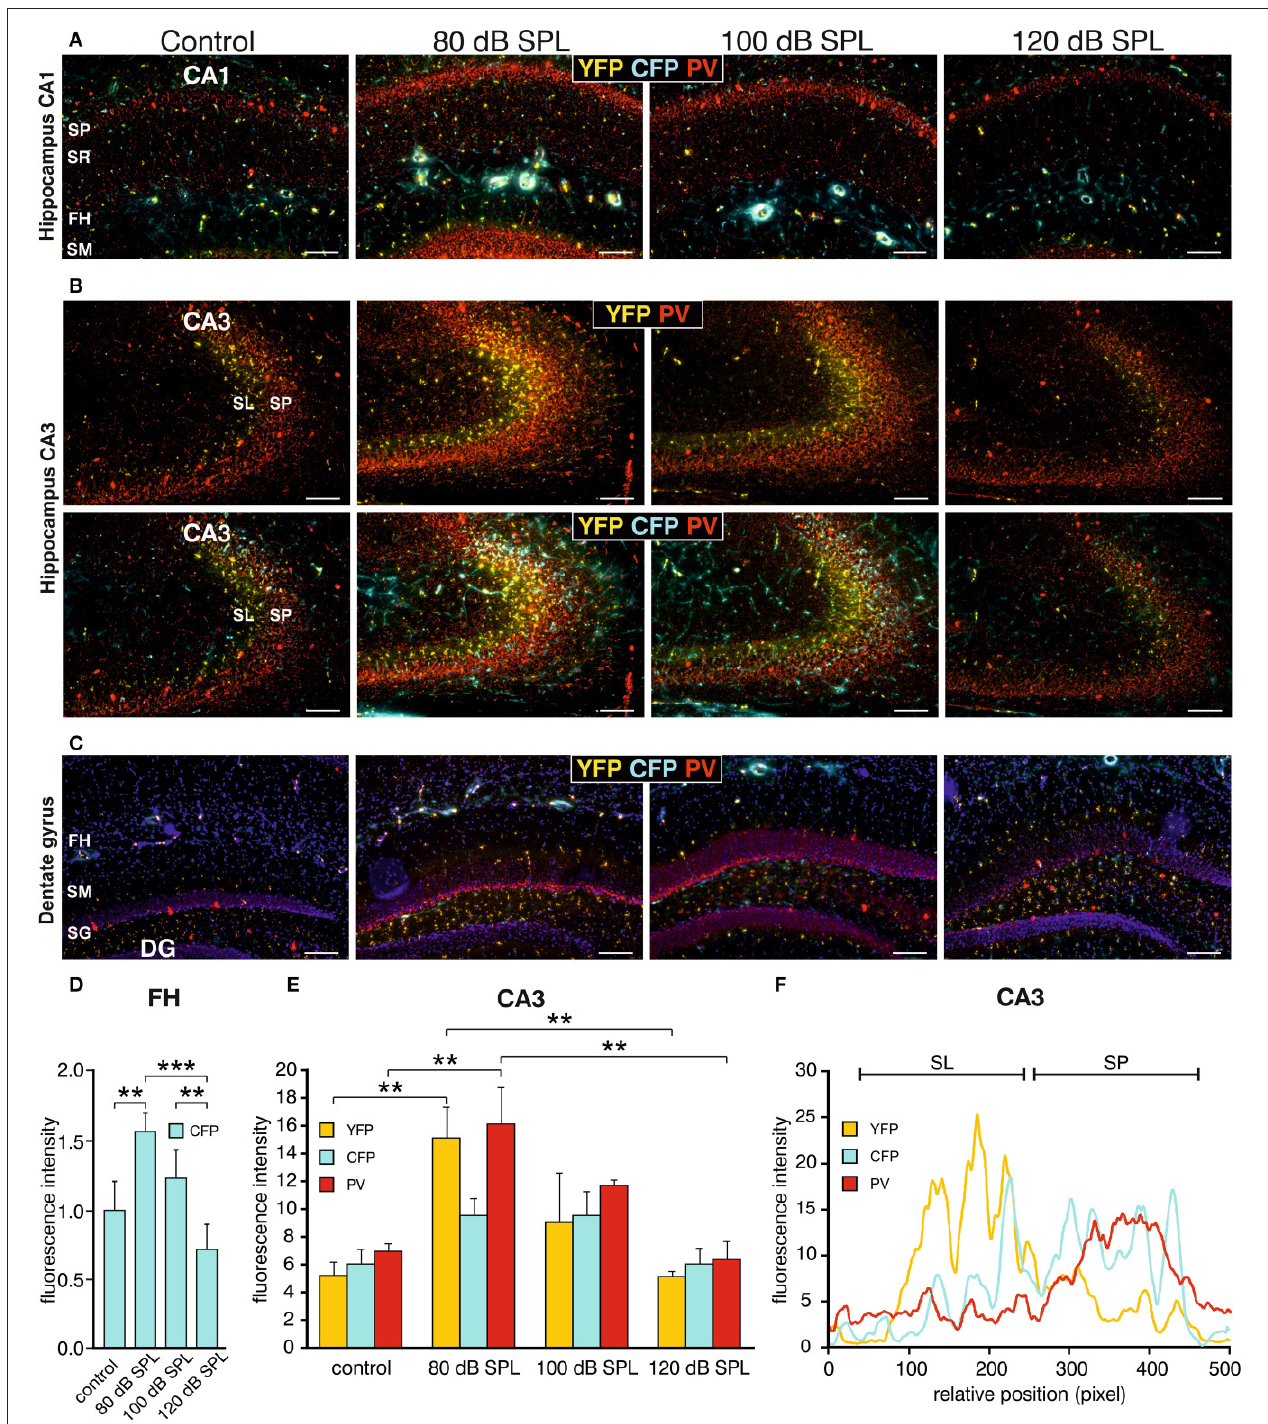
FIGURE 4 | Dynamic changes of Bdnf exon-IV and -VI transcripts and parvalbumin upon sound exposure in hippocampal circuits (Supplementary Video 1). (A–C) CFP/YFP fluorescence and parvalbumin immunostaining (PV, red) in dorsal hippocampal mouse slices 2 weeks after exposure to sham, 80, 100, or 120 dB SPL. Note a prominent dynamic change of PV (red) expression in the stratum pyramidale (SP) of the CA1 region (A) , in the stratum lucidum (SL) of the CA3 region ( n = 6 animals/group) (B) , and stratum granulosum (SG) of the dentate gyrus (DG) (C) concomitant to distinct changes in YFP and CFP. SM, stratum moleculare; SR, stratum radiatum; FH, fissura hippocampalis. Scale bars, 100 µ m. (D) Quantification of Bdnf exon-IV-CFP in capillary outlines at the level of the FH revealed a peak of fluorescence in 80 dB SPL exposed animals that declined below control levels in 120 dB SPL exposed animals. Data represented as mean ± SD. (E) Quantification of YFP, CFP, and PV intensities in the CA3 region in an area of 300 × 100 µ m following different sound exposure paradigms. Data represented as mean ± SEM. (F) Intensity profile of CFP, YFP, and PV along a line through the CA3 of a control mouse, perpendicular to the SP (length: approximately 390 µ m). Representative for four